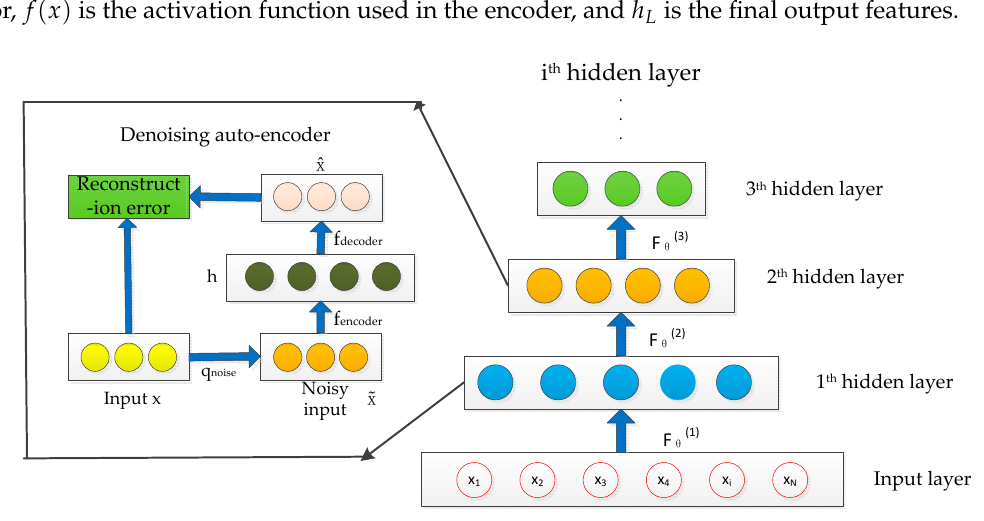
Figure 3. Stacked denoising auto-encoder (SDAE).